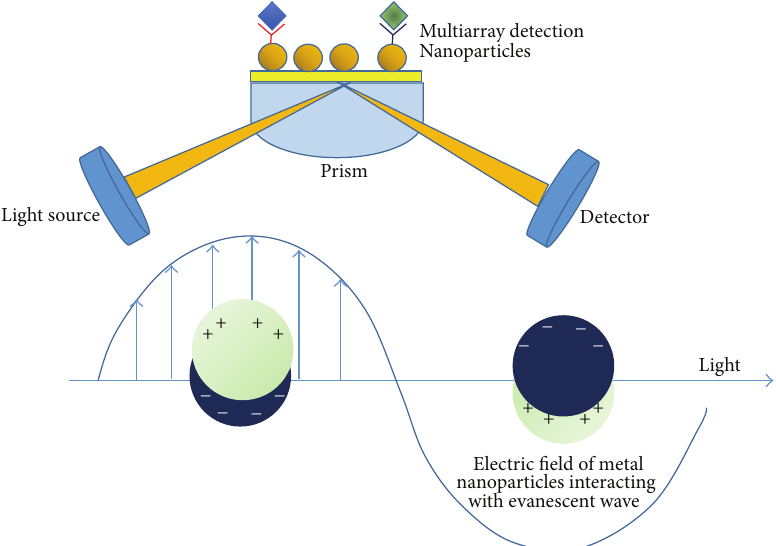
Figure 2: Scheme of localized SPR by using metal nanoparticles as amplification system to improve the IVD devices thanks to the local electric field/surface plasmon